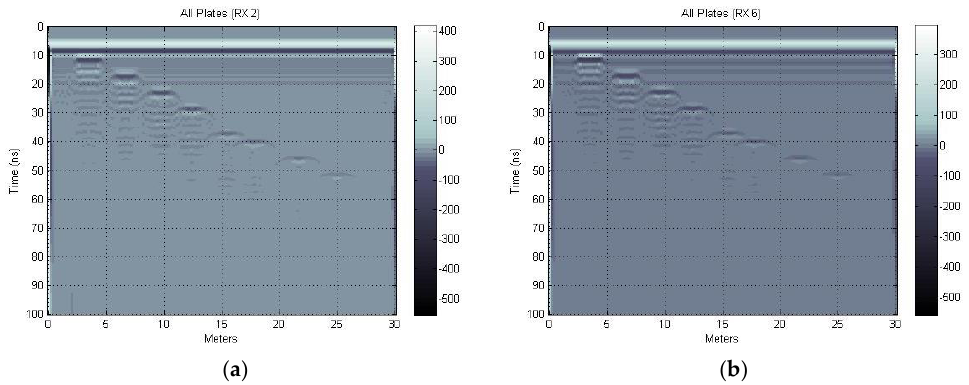
Figure A4. ( a ) slice Rx 2; ( b ) slice Rx 6; GPR results at 200 MHz for two 2-D slices of the 3-D analysis results. All eight of the simulated buried tin sheets are shown [1,4].